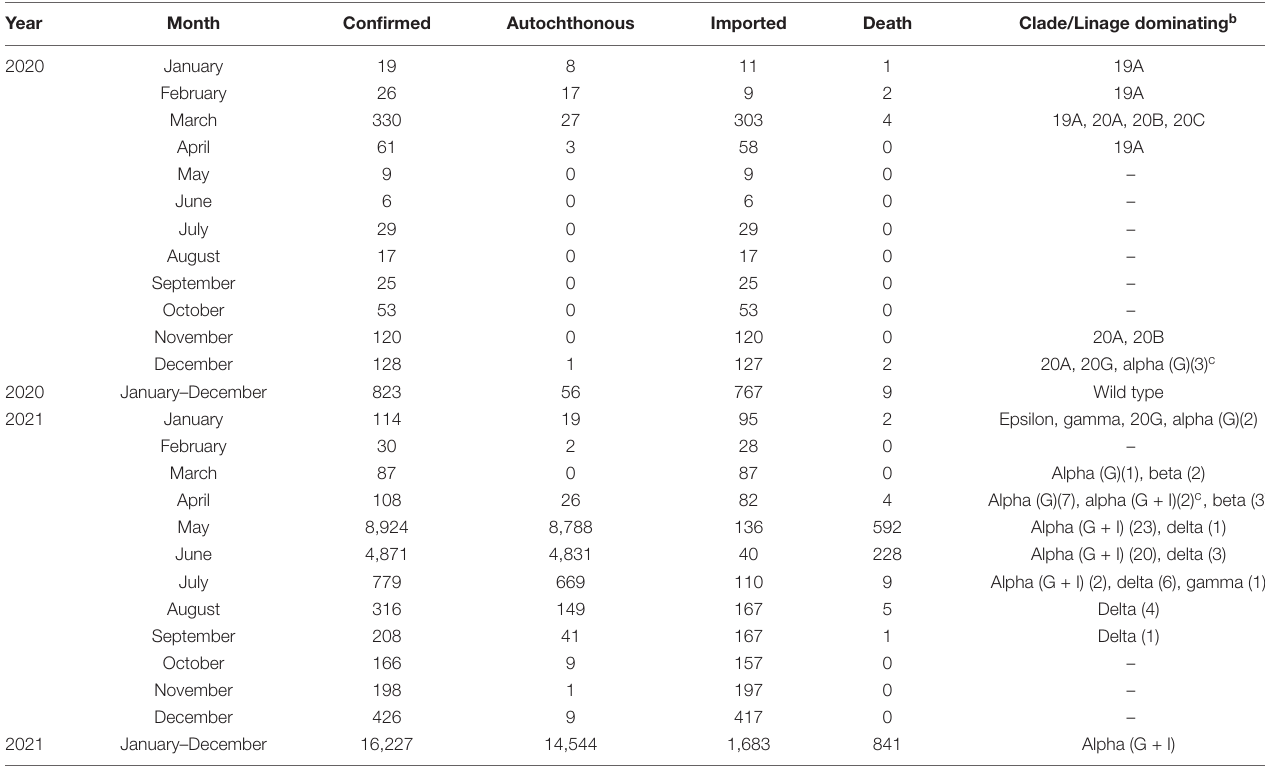
TABLE 3 | COVID-19 cases between January 2020 and December 2021. a